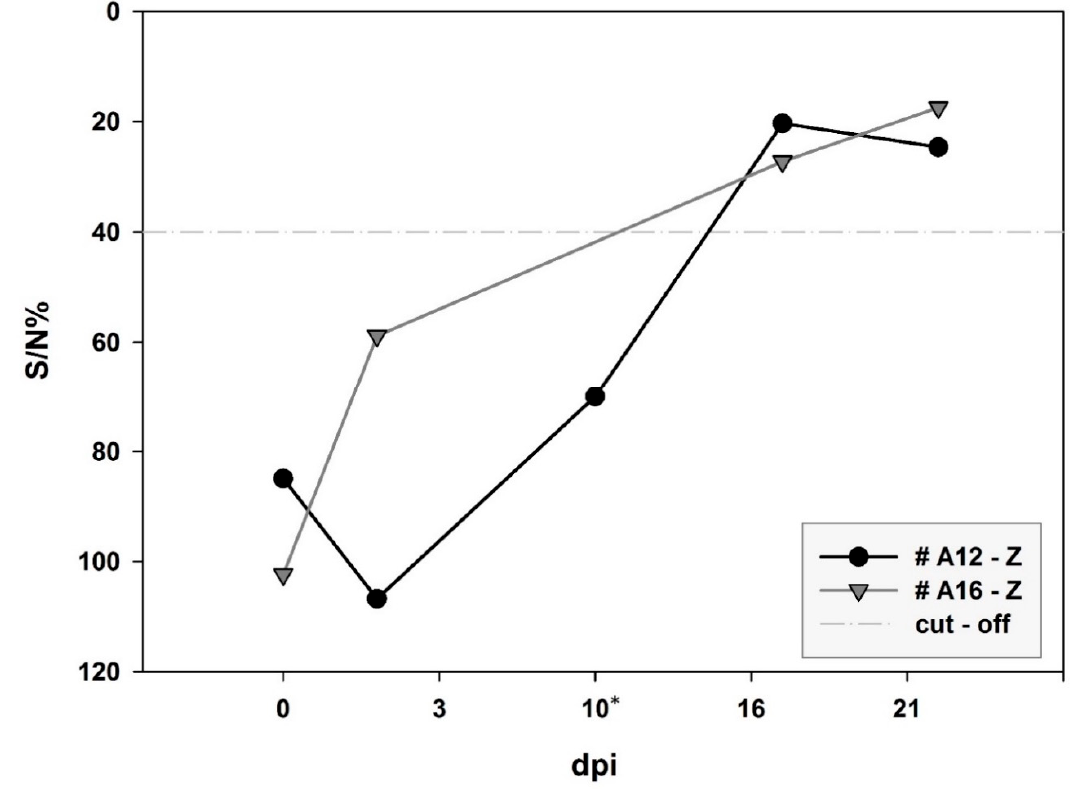
Figure 3. ID Vet Competition ELISA. * No serum was available from #A16-Z at 10 dpi.